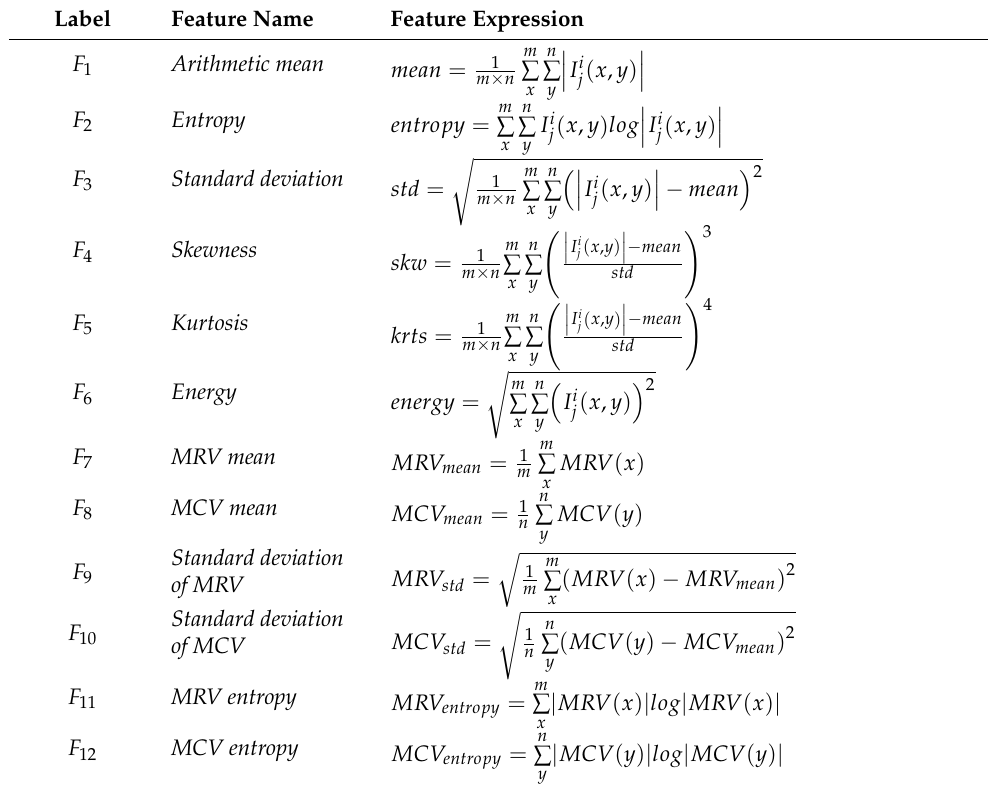
Table 4. Statistical and entropy-based features and their equations.